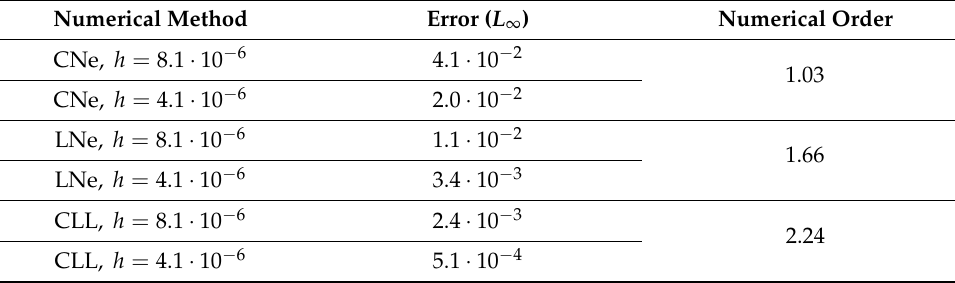
Table 3. Errors and numerical order of different algorithms for Experiment 3.